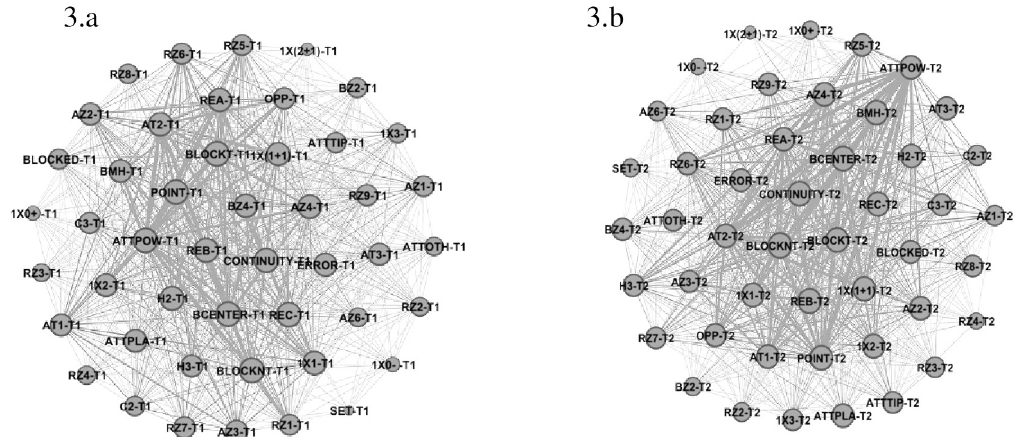
Fig 3. Sub-network with intra-team variability of Team 1 (3.a) and 2 (3.b).